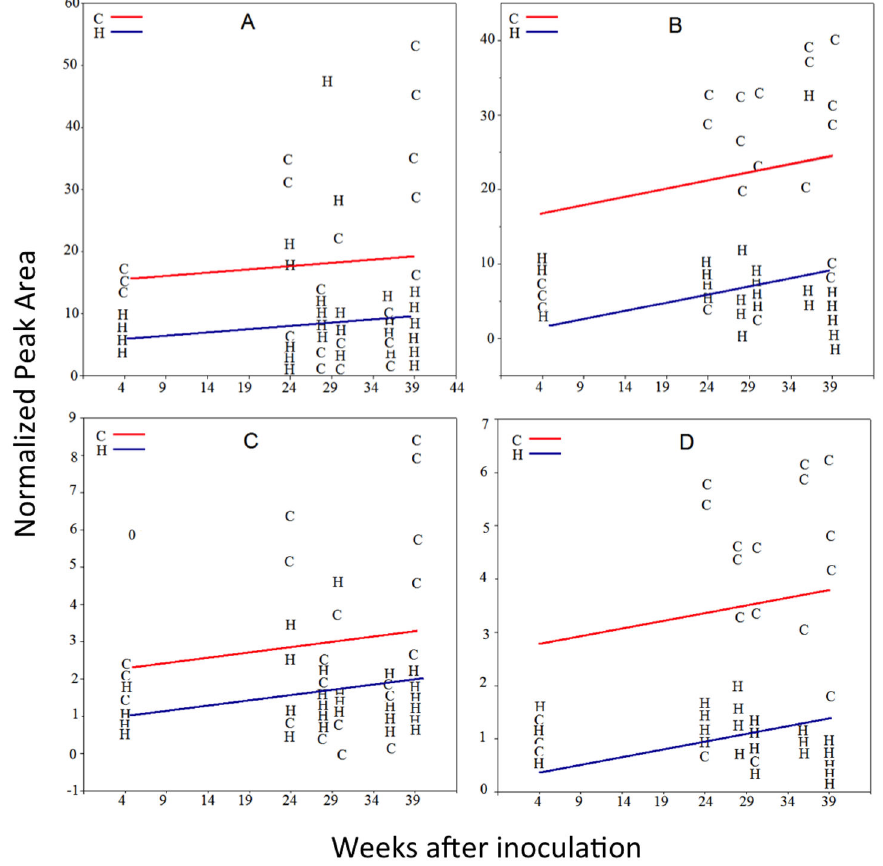
Figure 5. Relative amounts versus time (week) of different citrus leaf metabolites from controls and C Las-inoculated trees. A ) unknown 29 in ‘Valencia’ leaves; B ) unknown 29 in ‘Hamlin’ leaves; C ) unknown 39 in ‘Valencia’ leaves; D ) unknown 39 in ‘Hamlin’ leaves.